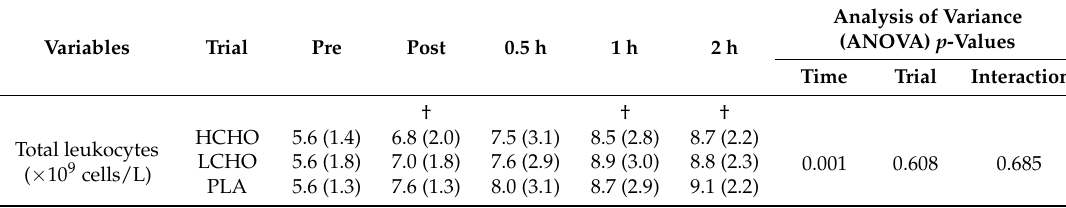
Table 1. Changes in circulating blood cell counts in response to endurance